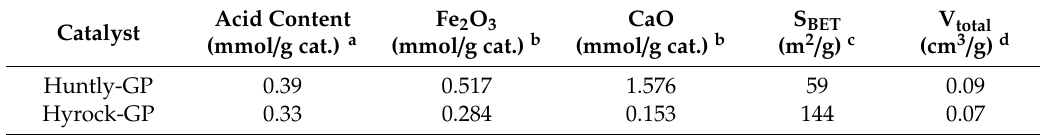
Figure 6. Porosity analysis of Huntly-GP catalyst. ( a ) Transmission electron microscopy (TEM) image, ( b ) N 2 sorption isotherm. Table 1. Chemical and physical characteristics of the developed FA-based catalysts.